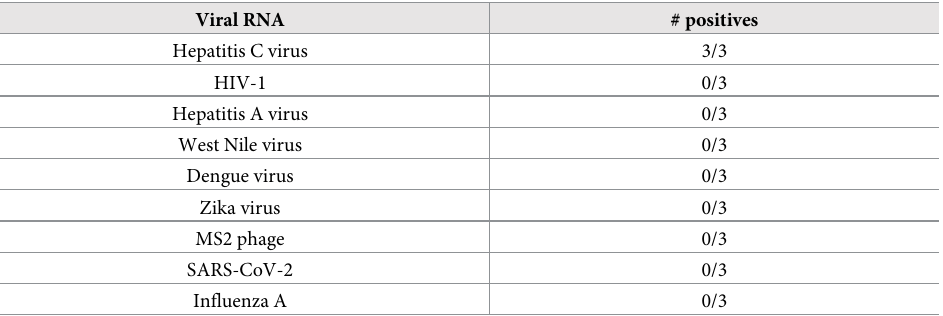
Table 2. Preliminary analytical specificity screening. Reactivity of RT-RPA to viral RNA from common bloodborne viruses and widely circulating respiratory viruses. RPA reactions were performed with 1000 cps/rxn for all viral nucleic